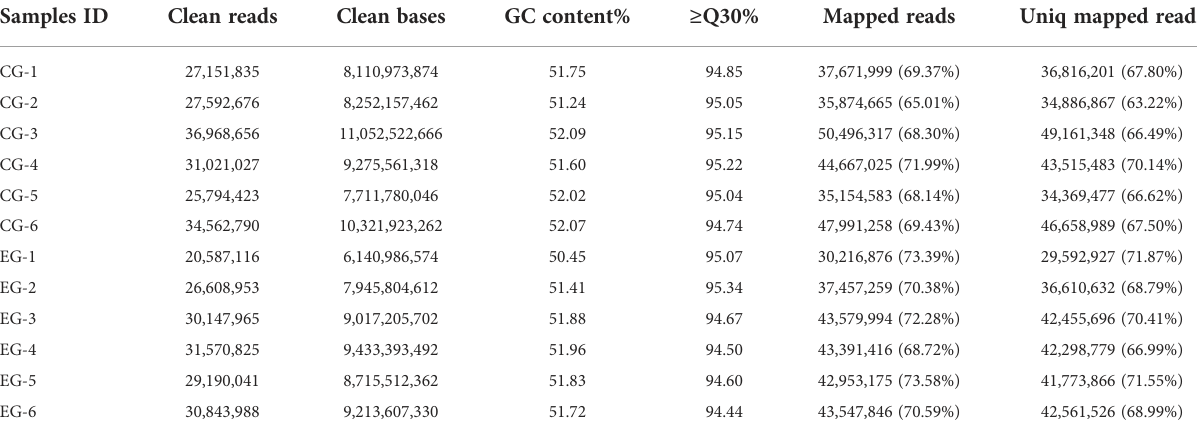
TABLE 4 Characteristics of the reads from the jejunum libraries of 12 ducks.